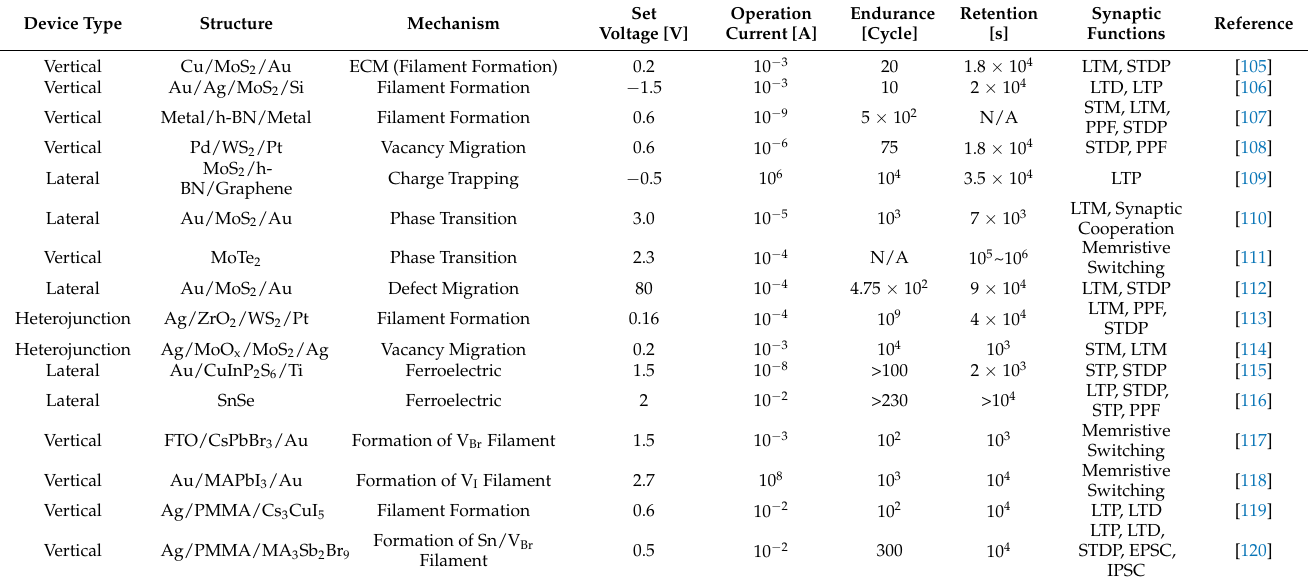
Table 1. Various Memristive Devices and their